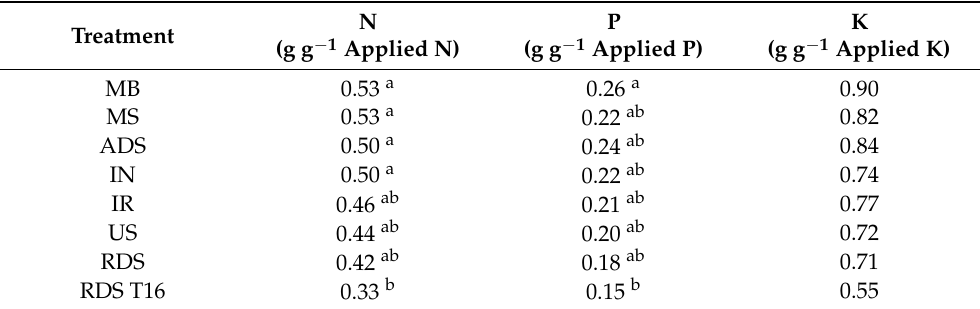
Table 2. N, P and K apparent nutrient recovery efficiency (ANR) of evaluated treatments, means of three replicates. For each parameter, values followed by different letters in the same column, are significantly different based on the Tukey test ( p < 0.05). The absence of letters in the column indicates non-significant differences.